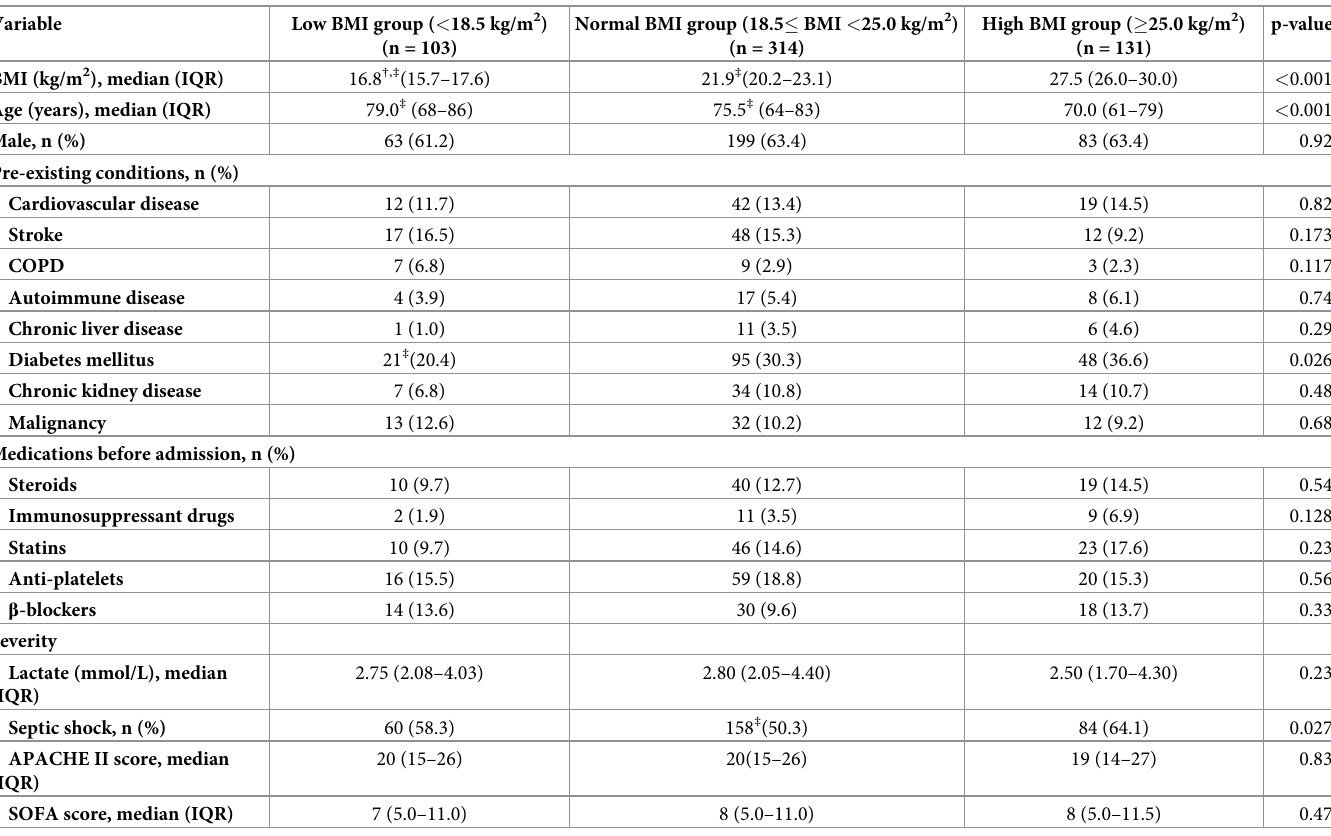
Table 1. Patient demographics and clinical data of the three study groups defined by the BMI